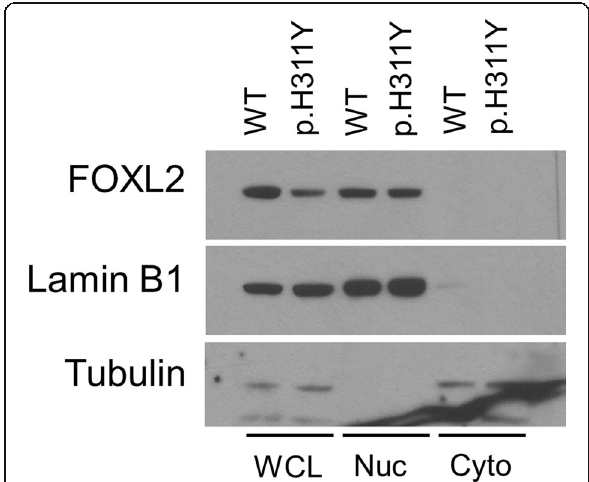
Fig. 3 Subcellular distribution of WT and p.H311Y mutant FOXL2 . Nuclear (Nuc) and cytosolic (Cyto) extracts, as well as whole cell lysate (WCL) of cells transfected with WT or p.H311Y FOXL2 were subjected to Western blotting. Both WT and mutant FOXL2 showed nuclear localization. Lamin B1 and tubulin were used as markers of nuclear and cytoplasmic fractions,